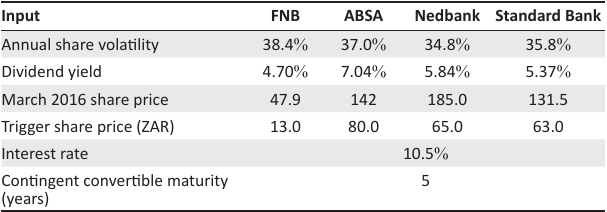
TABLE 4: Trigger share prices derived from Figures 7 and 8 with market-related pricing model inputs.